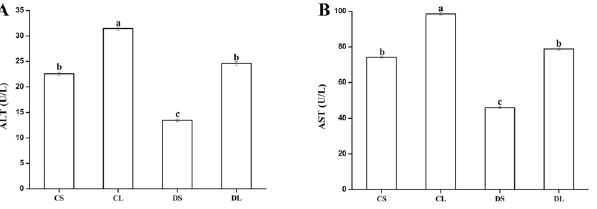
Fig 4. Effects of DMG-Na on ALT (A) and AST (B) activities in LPS-injected mice serum. Values are mean ± SEMs (n = 10). Mean of a variable without a common letter differ, P < 0.05. Alanine aminotransferase (ALT); Aspartate aminotransferase (AST). CS, gastric intubation in mice with 0 mg DMG-Na/0.3 ml sterile saline solution for 28 days and intraperitoneal injection with 100 μ g/kg body weight of sterile saline solution at 29 day; CL, gastric intubation in mice with 0 mg DMG-Na/0.3 ml sterile saline solution for 28 days and intraperitoneal injection with 100 μ g/kg body weight of LPS at 29 day; DS, gastric intubation in mice with 12 mg DMG-Na/0.3 ml sterile saline solution for 28 days and intraperitoneal injection with 100 μ g/kg body weight of sterile saline solution at 29 day; DL, gastric intubation in mice with 12 mg DMG-Na/0.3 ml sterile saline solution for 28 days and intraperitoneal injection with 100 μ g/kg body weight of LPS at 29